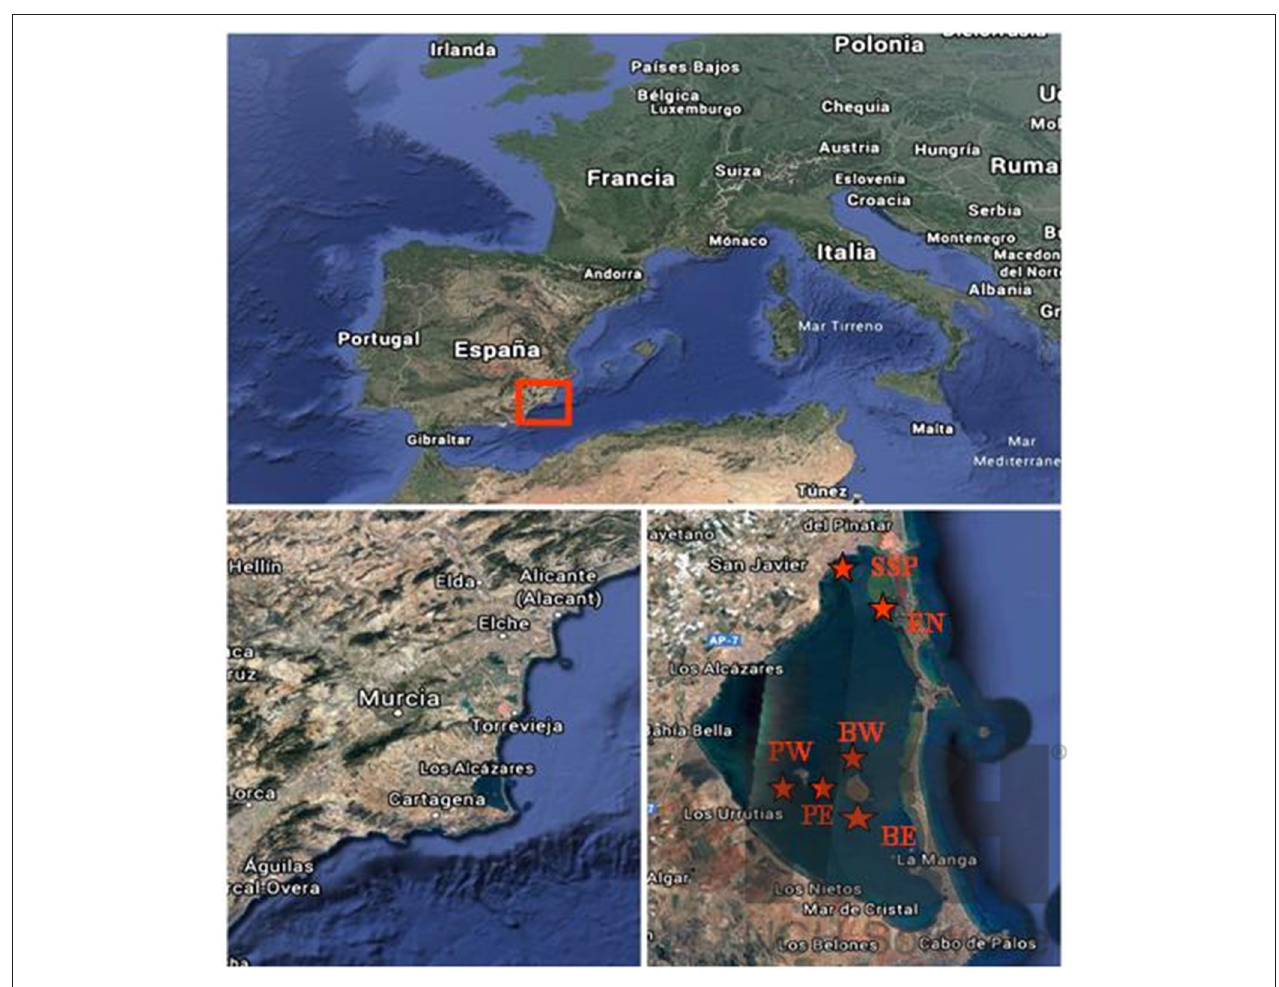
FIGURE 1 | Location of the Mar Menor coastal lagoon: Two localities in the surrounding of the Baron Island: BE (37 ◦ 41 ′ 27.14 ′′ N, 0 ◦ 45 ′ 01 ′′ W) and BW (37 ◦ 41 ′ 45.89 ′′ N, 0 ◦ 46 ′ 37.8 ′′ W); two in La Perdiguera Island: PE (37 ◦ 41 ′ 55.7 ′′ N, 0 ◦ 47 ′ 47.18 ′′ W) and PW (37 ◦ 41 ′ 55.03 ′′ N, 0 ◦ 48 ′ 05.46 ′′ W), one locality in Las Encañizadas EN (37 ◦ 47 ′ 41.26 ′′ N, 0 ◦ 45 ′ 54.31 ′′ W) and the port of San Pedro del Pinatar marina SSP (37 ◦ 49 ′ 00.13 ′′ N; 0 ◦ 47 ′ 03.71 ′′